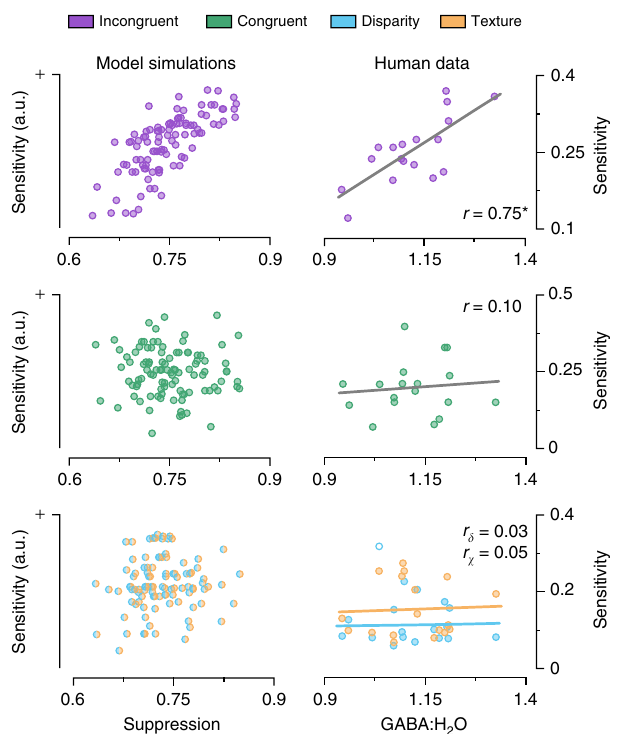
Fig. 4 Model predictions and empirical measurements on the relationship between behavioural sensitivity and the level of suppression. The left column shows proscriptive integration model simulation results that manipulated the inhibitory gain in the model: more suppression leads to higher model sensitivity for incongruent cues (top row), but not congruent (middle row) or single cues (bottom). The right column shows the results of MRS measurements that quanti fi ed GABA around V3B/KO and related this to between-subject differences in behavioural sensitivity. Consistent with the model simulations, we found a signi fi cant positive correlation between human observers ’ GABA concentration in the voxel centred on V3B/KO and perceptual sensitivity to incongruent-cue stimuli ( n = 18, Pearson ’ s correlation r = 0.75, P = 3.8e − 4 , CI 95% = [0.40, 0.91]; con fi dence intervals are corrected for multiple comparisons; top right), but not to congruent- or single-cue stimuli ( n = 18, congruent: Pearson ’ s r = 0.10, P = 0.68, middle right; disparity: Pearson ’ s r = 0.03, P = 0.92; texture: Pearson ’ s r = 0.05, P = 0.85; bottom right). Asterisks highlight signi fi cant differences P < 0.05. Each datum represents measures from one participant; bivariate outliers are shown as empty